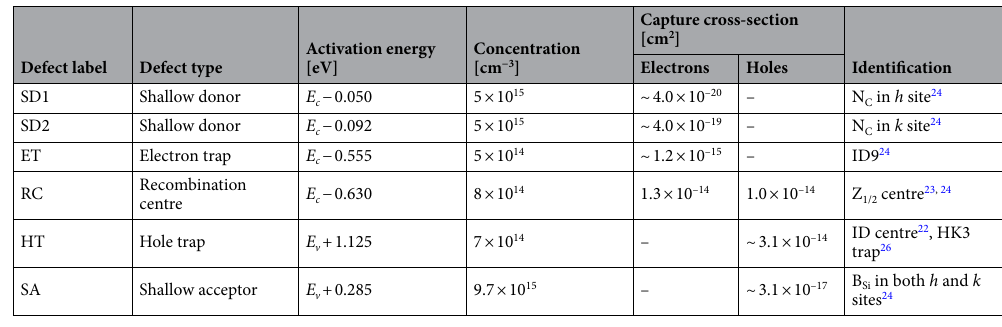
Table 1. Properties of defect centres applied for simulation of kinetics of 4H-SiC material 16, 17 .